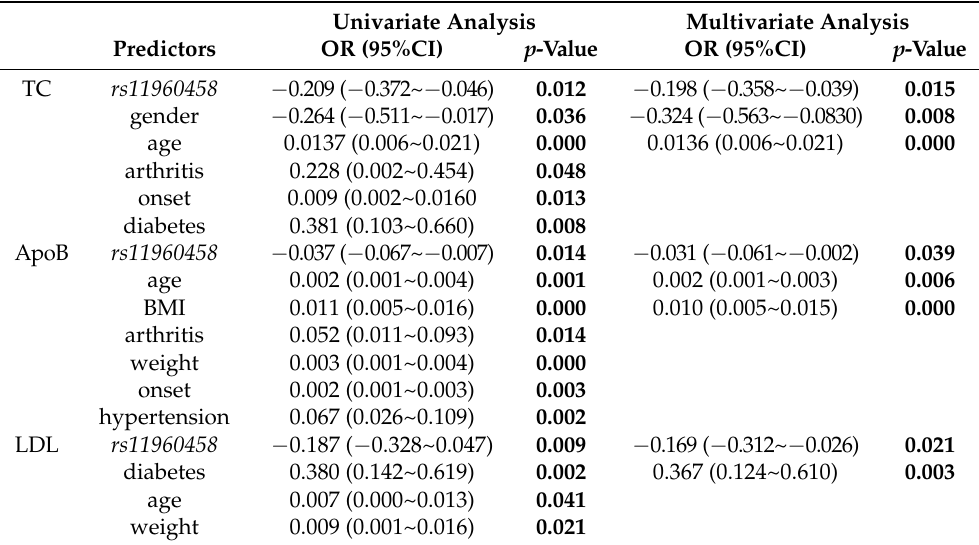
Table 2. Univariate and multivariate analyses of clinical factors and AnxA6 polymorphism associated with the levels of pro-atherogenic lipids in 262 psoriatic patients.